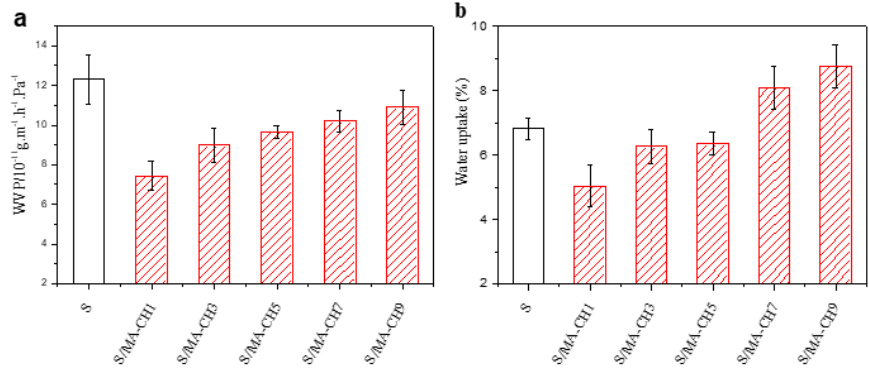
Figure 6. Water vapor transmission rate ( a ) and water uptake ( b ) of S films, S / CH 1% films, S / CH 3% films, S / CH 5% films, S / CH 7% films, S / CH 9%, S / MA-CH 1% films, S / MA-CH 3% films, S / MA-CH 5% films, S / MA-CH 7% films, and S / MA-CH 9% films.